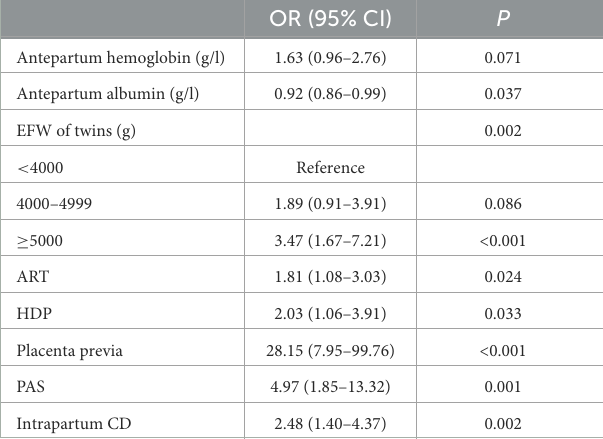
TABLE 3 Multivariable logistic regression analyses of the risk factors for PPH after cesarean delivery of twin pregnancies.